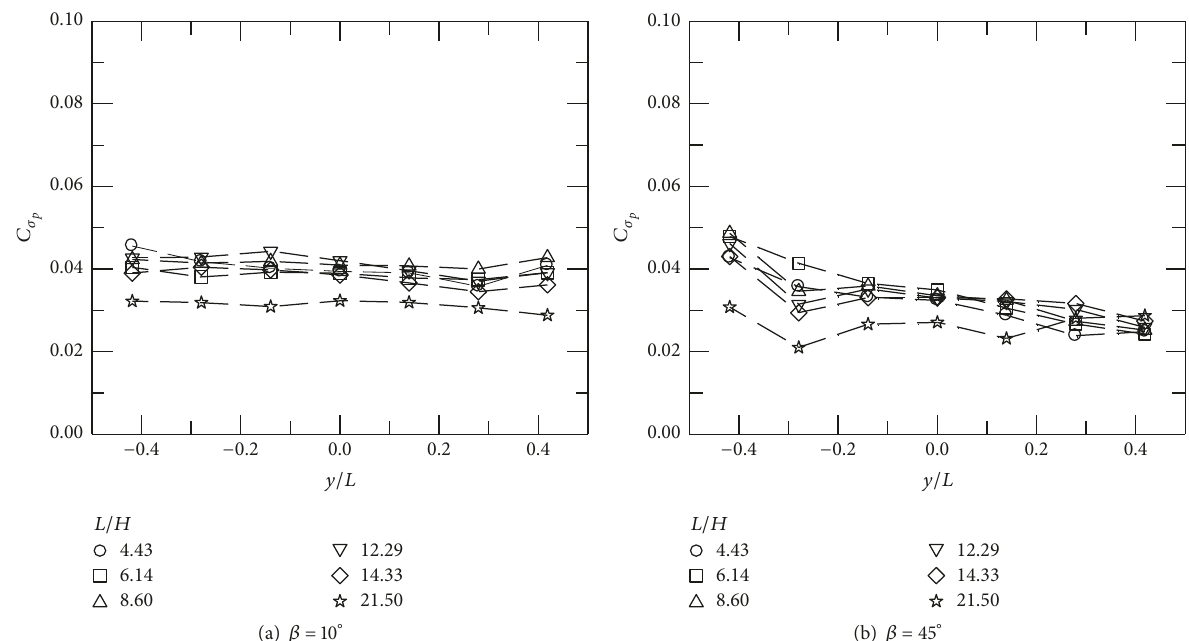
Figure 10: Span-wise fluctuating pressure distributions for M = 0.83: (a) 𝛽 = 10 ∘ and (b) 𝛽 = 45 ∘